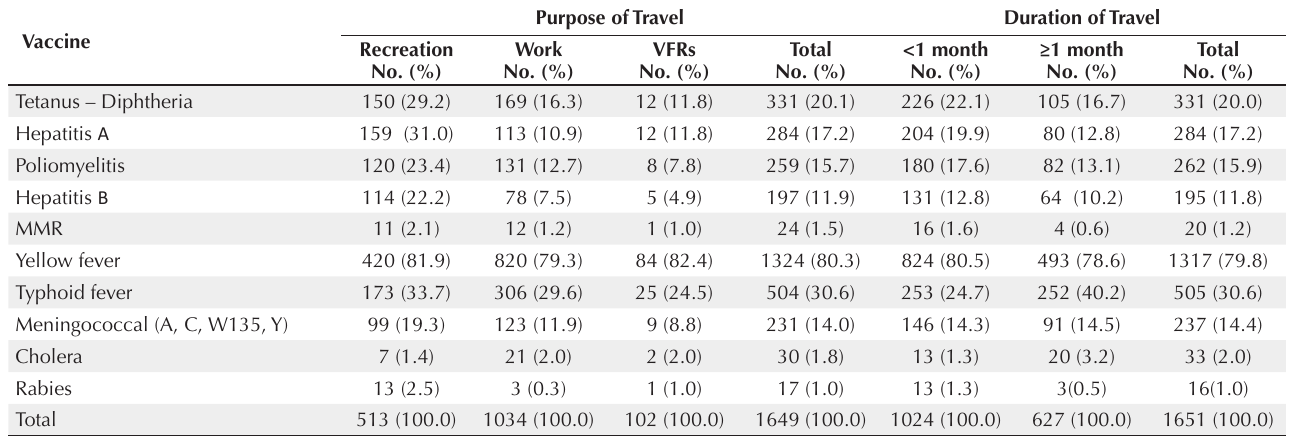
Table 5. Vaccination Rates According to Purpose and Duration of Travel